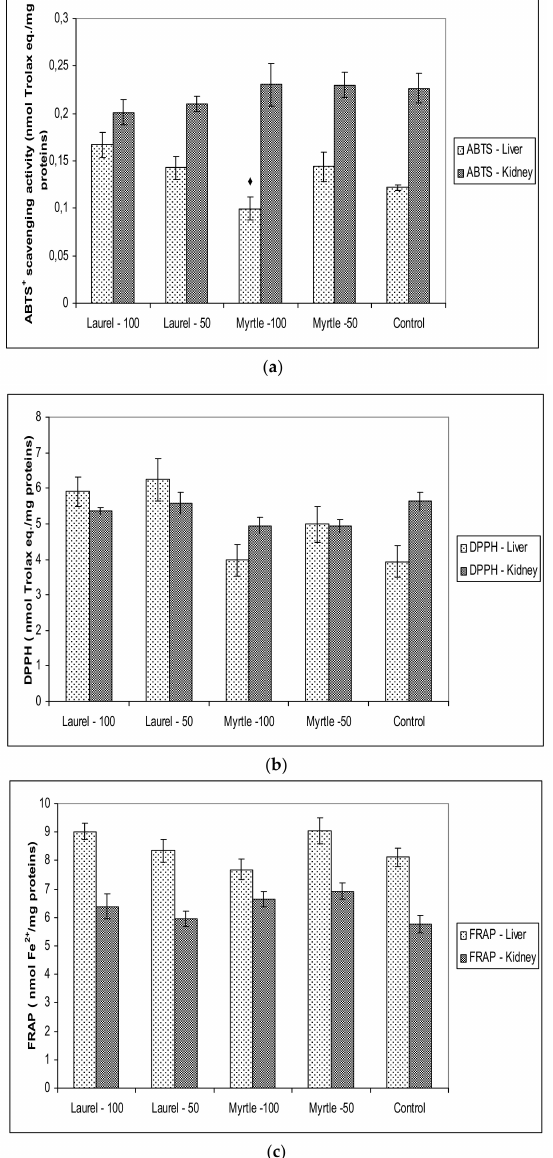
Figure 4. The effect of Laurel and Myrtle extract on the antioxidative capacity of the liver and kidney tissues homogenates measured by ABTS ( a ), DPPH ( b ) and FRAP ( c ) activity. Male rats ( n = 5) were administered Laurel and Myrtle extracts ig at a dose of 50 and 100 mg/kg once a day for 14 days. The control group was treated ig with saline. The results are expressed as the mean value of each (cid:7) experimental group ± SE of the mean of two different observations. Significantly different in (cid:7) p relation to Laurel-100 ( <